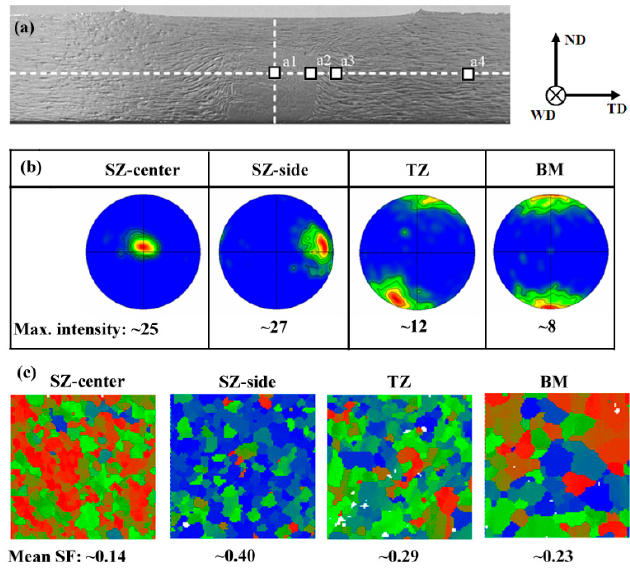
Figure 4. EBSD orientation maps of various regions in FSW AZ31 alloy: ( a ) measurement positions; ( b ) {0001} pole figures; and ( c ) SF maps of basal slip in various regions during the transverse tensile tests [84].